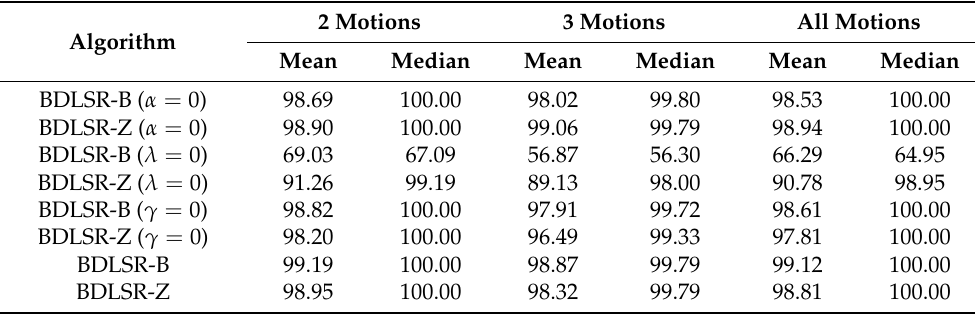
Table 6. A comparison of the accuracy (%) results when using the Hopkins 155 dataset with 2F- dimensional data in the ablation studies.